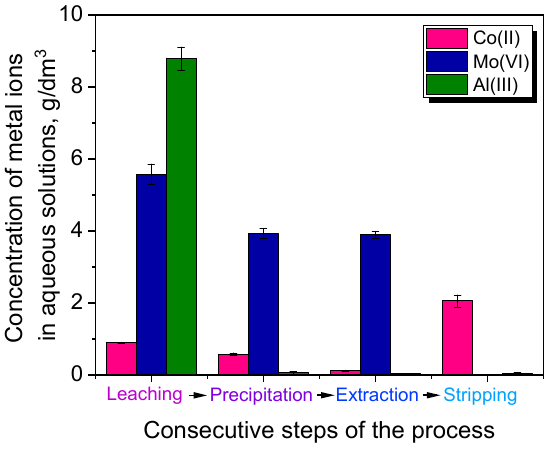
Figure 7. Flow of Co(II) ( ), Mo(VI) ( ) and Al(III) ( ) in consecutive steps of the proposed process.